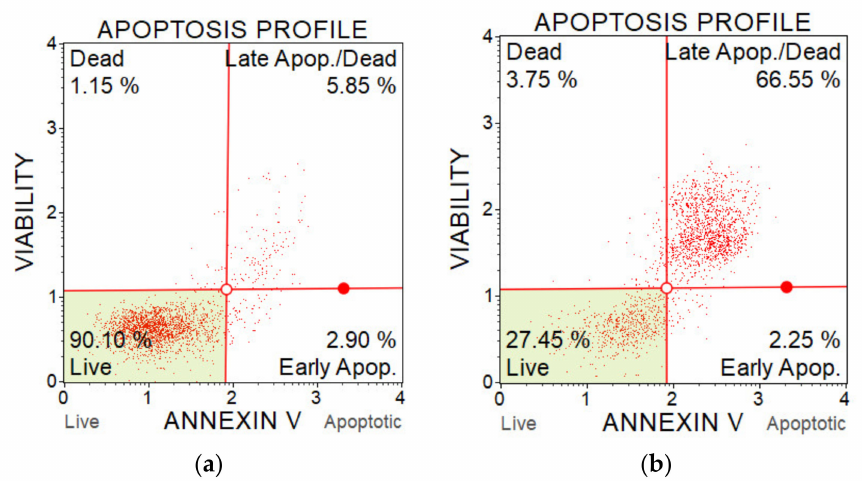
Figure 18. Flow cytometry plots from apoptosis analysis of A375 cells after PAM application. ( a ) Control sample (untreated medium); and ( b ) PAM activated for 5 min, 100%